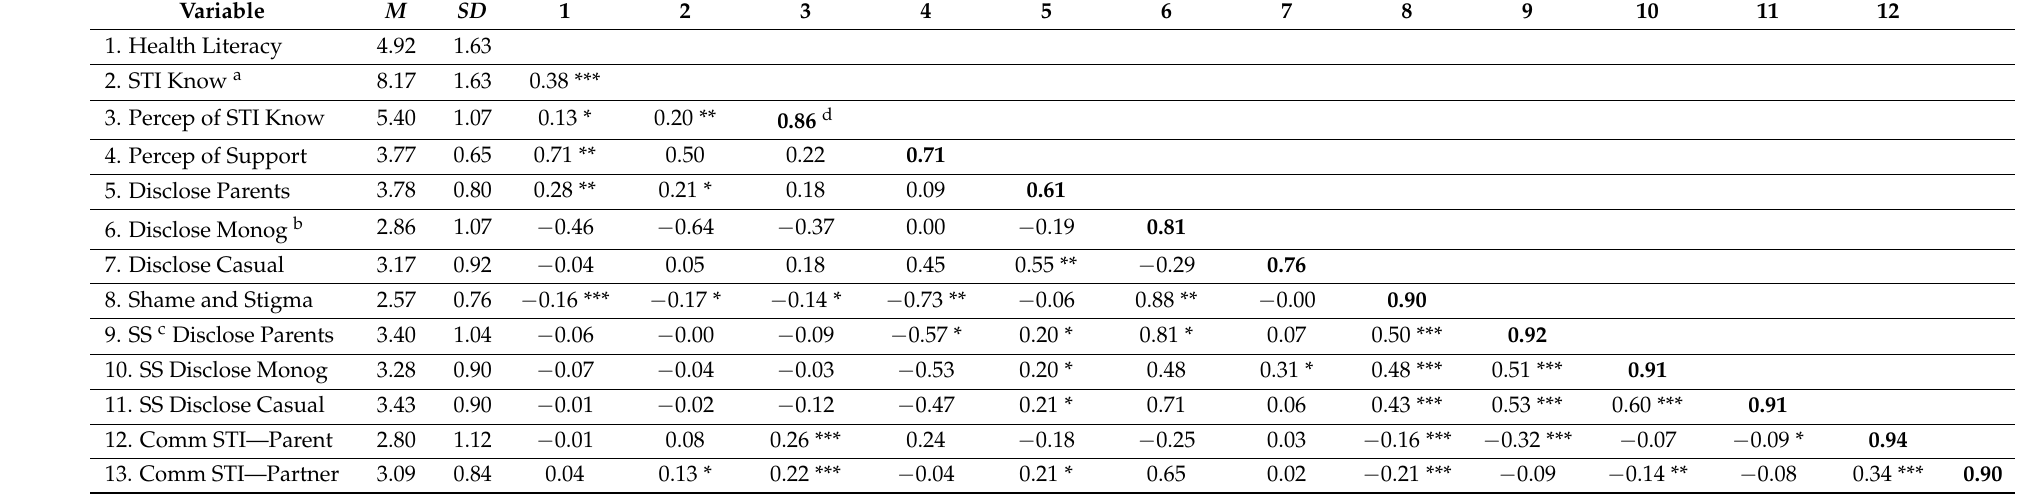
Table 1. First Person Independent and Dependent Variables Correlation